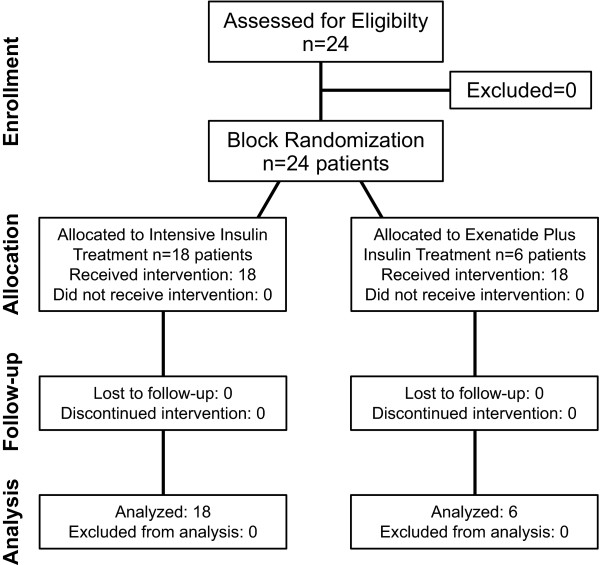
CONSORT diagram. Eligibility and enrollment of patients.